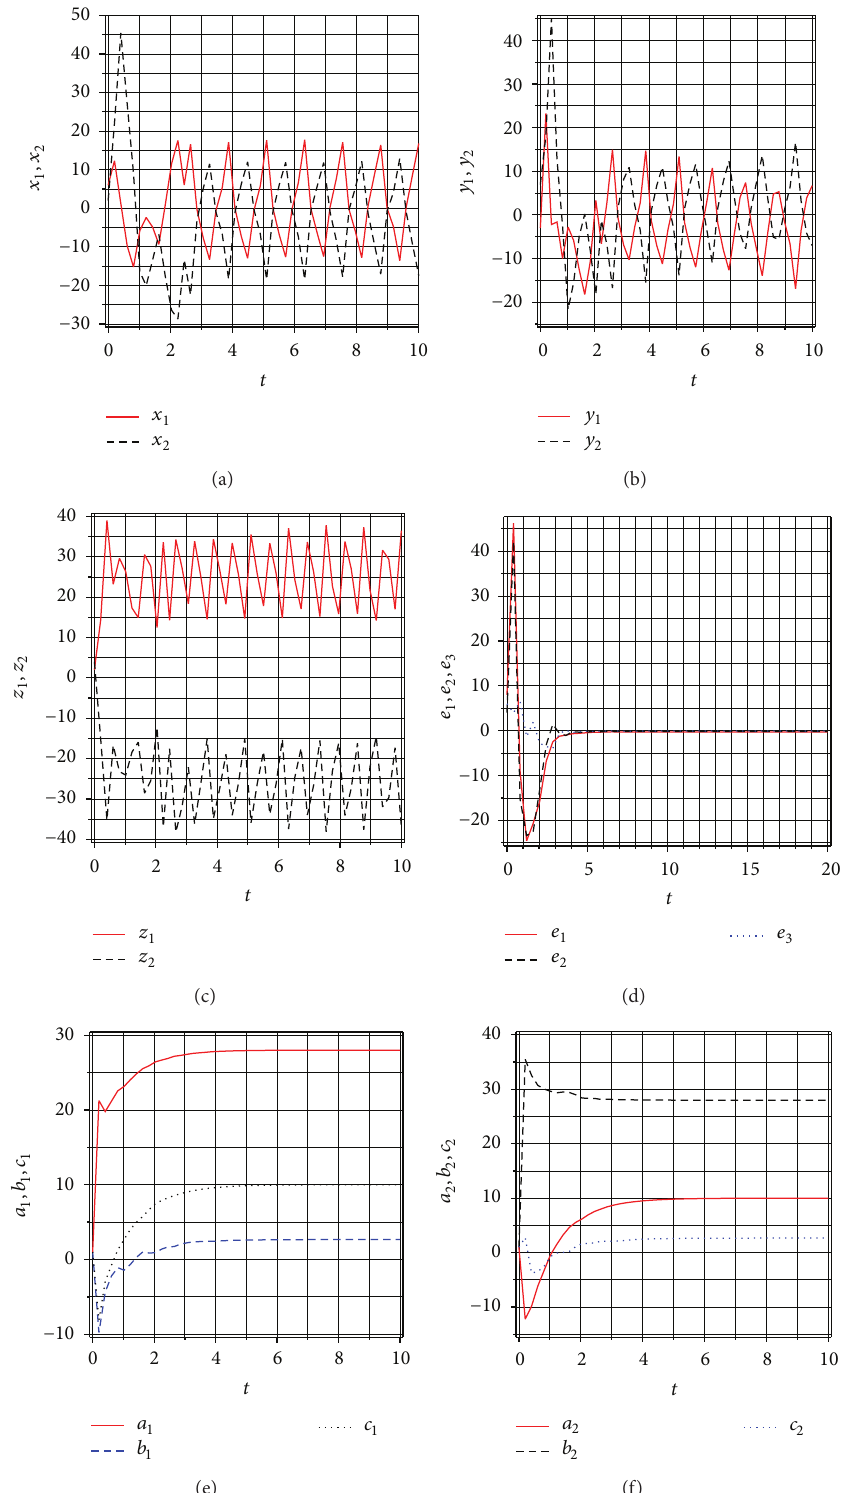
Figure 5: State trajectories of drive system (22) and response system (23): (a) signals 𝑥 1 and 𝑥 2 ; (b) signals 𝑦 1 and 𝑦 2 ; (c) signals 𝑧 1 and 𝑧 2 ; (d) the error signals 𝑒 1 , 𝑒 2 , and 𝑒 3 of the hyperchaotic Lorenz and Lorenz systems under the controller (26) and the parameters update law (27); (e)-(f) changing parameters 𝑎 1 , 𝑏 1 , 𝑟 1 and 𝑎 2 , 𝑏 2 , 𝑐 2 of the hyperchaotic Lorenz and Lorenz systems with time 𝑡